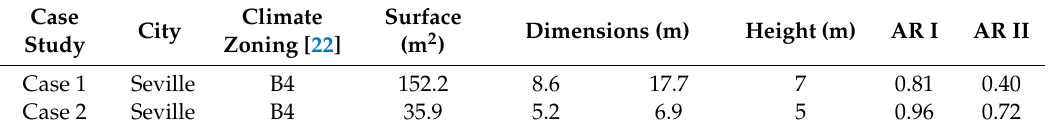
Table 1. Climate and geometric data of the case studies.